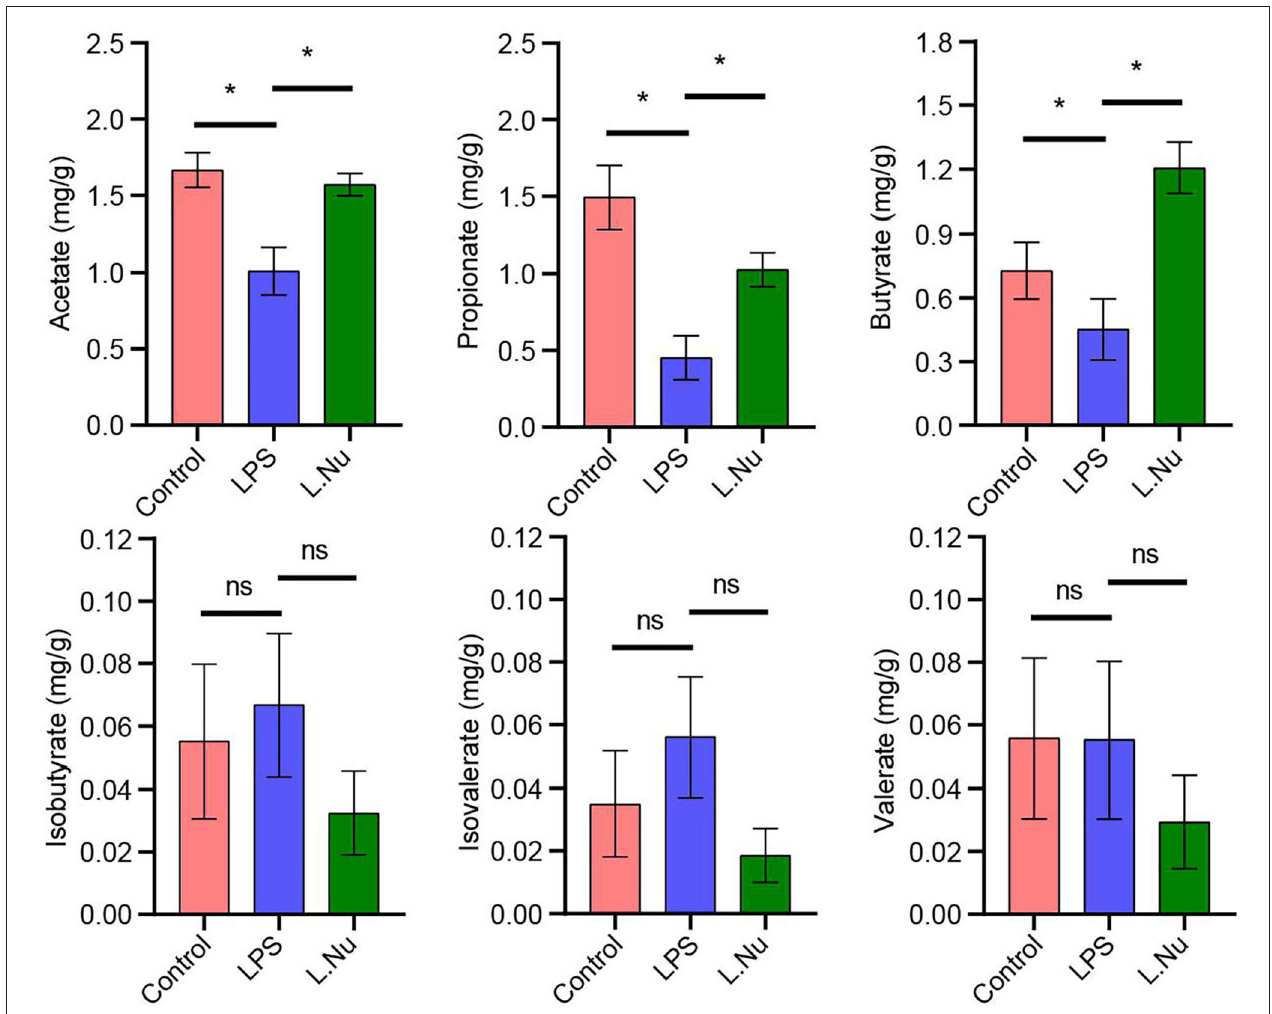
FIGURE 5 | NU9056 in LPS-induced mice might be associated with SCFA. GC-MS determination of the concentration of SCFA consisting of acetate, propionic, butyric, isobutyric, isovalerate, and valerate in the stools of mice. * P < 0.05; ns, not